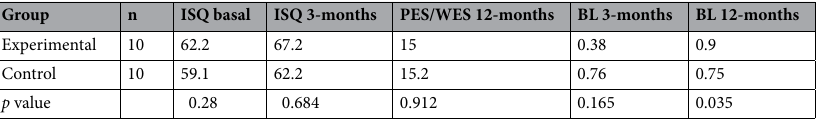
Table 4. Summary statistics by ramdomization arm and p -values for ISQ values (at baseline and 3-months), PES/WES values at 12-months, BL values (at 3-months and